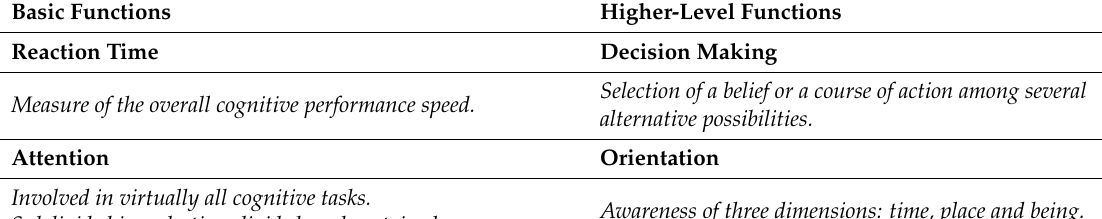
Table 2. Basic and higher-level cognitive functions. Basic